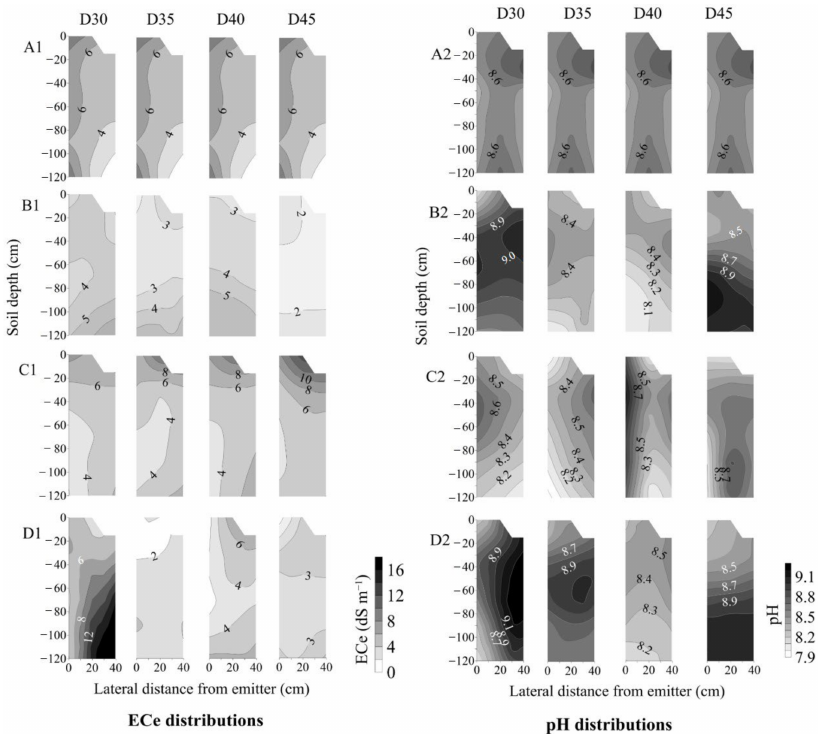
Figure 3. Spatial and temporal distributions of the electrical conductivity of the saturated soil extracts (ECe) and the pH of the saturated soil extracts (pH) in the different treatments. ( A1 , A2 ) May in 2018; ( B1 , B2 ) September in 2018; ( C1 , C2 ) May in 2019; ( D1 , D2 ) September in 2019. D30 , D35 , D40 , and D45 indicated treatments with sowing densities of 41,667, 35,714, 31,250, and 27,778 plants ha − 1 , respectively. Table 3. The average ECe in the 0–40 cm and 0–120 cm soil layers during the different sampling periods.